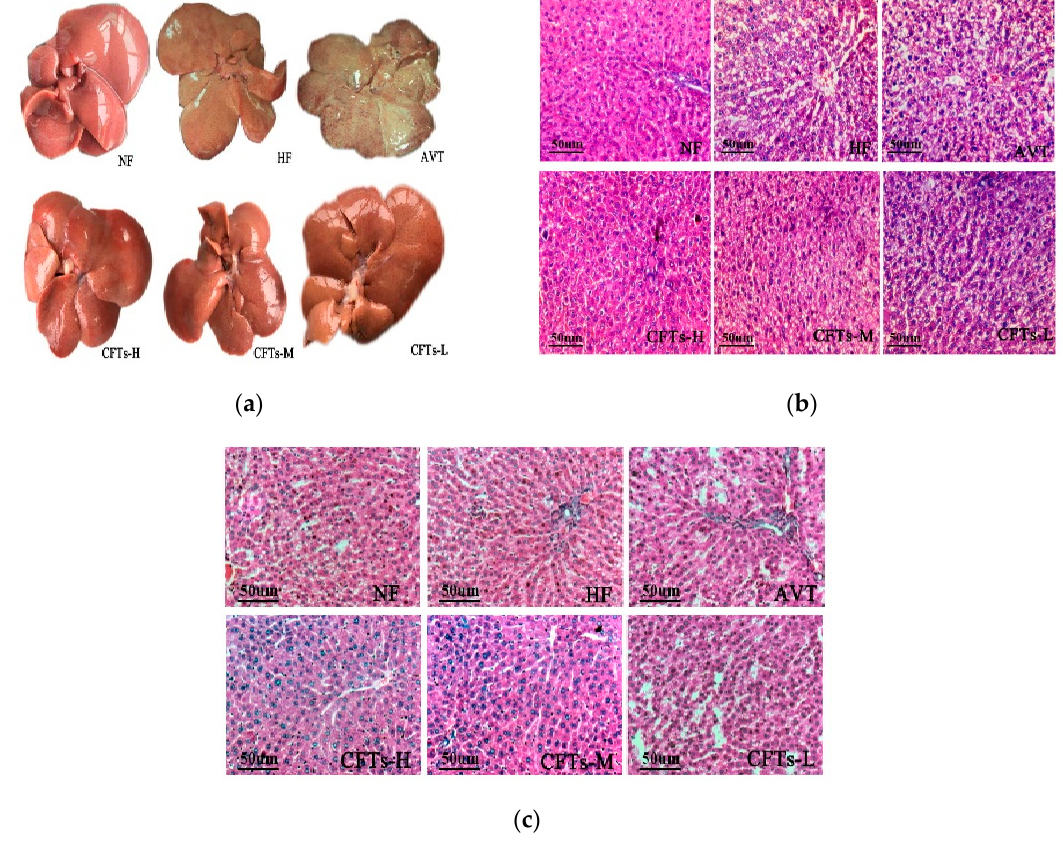
Figure 6. The whole liver ( a ), slices of liver ( b ) and kidney ( c ) from different groups of rats (200 × ) after 6 weeks of treatment. Tissue sections were stained with hematoxylin and eosin (H & E).